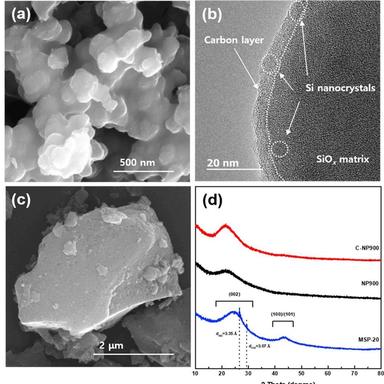
(a) FESEM image and (b) HRTEM image of the C-coated Si/SiOx nanospheres, (c) FESEM image of the activated carbon, and (d) powder XRD patterns of the Ccoated Si/SiOx nanospheres and activated carbon (MSP-20).